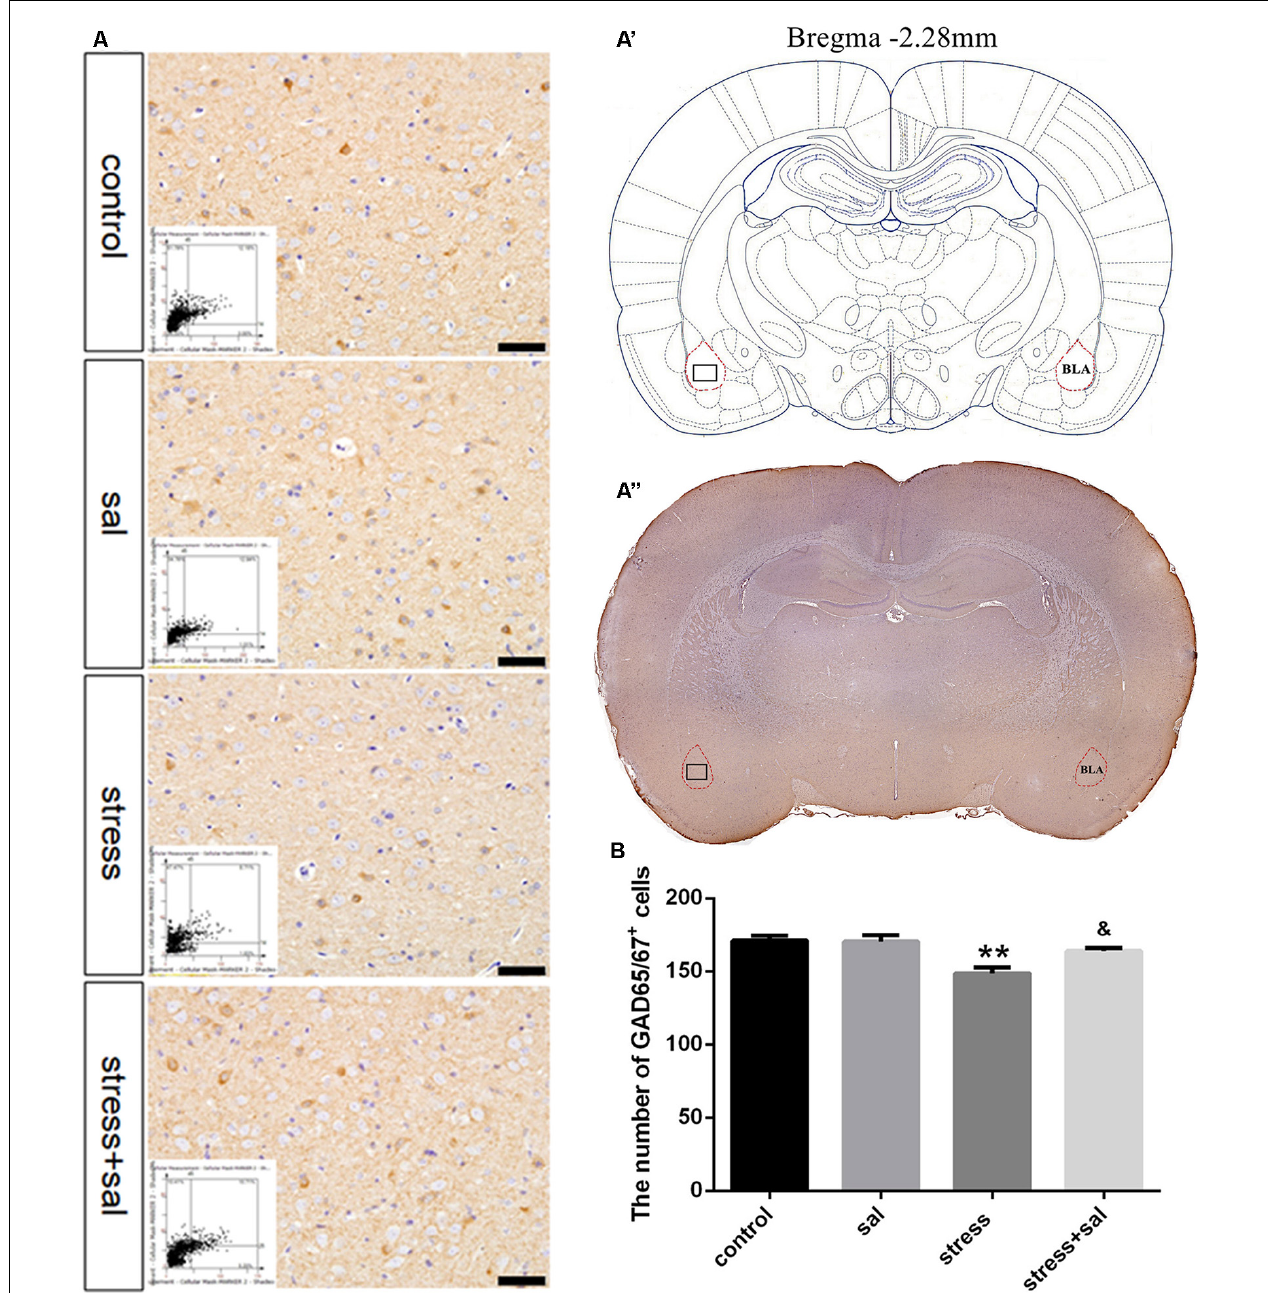
FIGURE 5 | Inhibition of the PERK pathway alleviated GABAergic neuron injury. (A) Representative images showing GAD65/67 immunohistochemistry in the BLA. Images obtained by MMTC are shown in the lower left corners. Bars = 50 µ m. The analyzed region within the BLA is schematically illustrated in (A (cid:48) ) (diagram modified from Paxinos and Watson, 2007) and (A”) (GAD65/67 immunohistochemistry). (B) Quantitative MMTC analysis. Data are shown as mean ± SEM, ∗∗ P < 0.01 vs. control group, & P < 0.05 vs. stress group ( n =